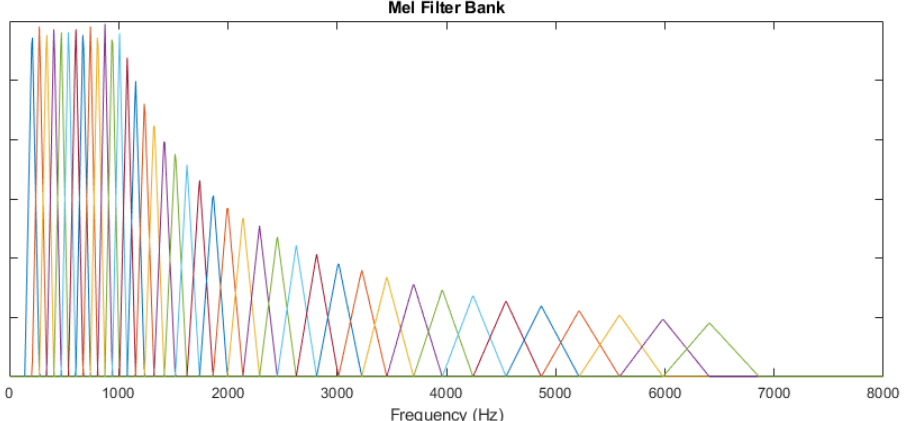
Figure 4. Mel triangular filter